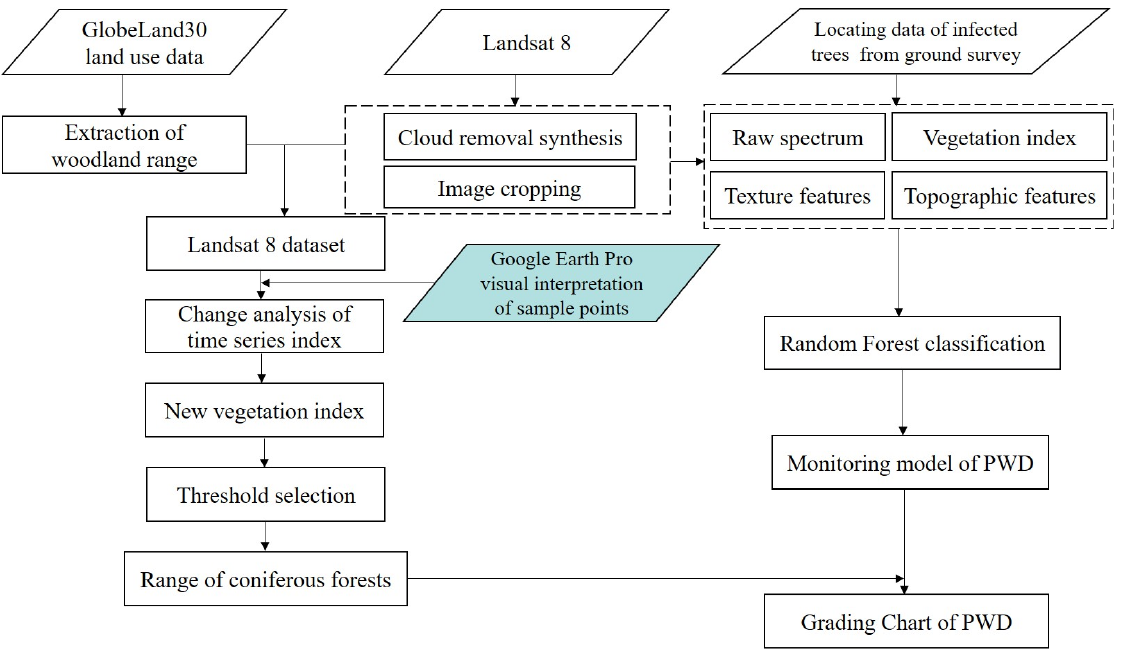
Figure 2. Technical route chart of this study.